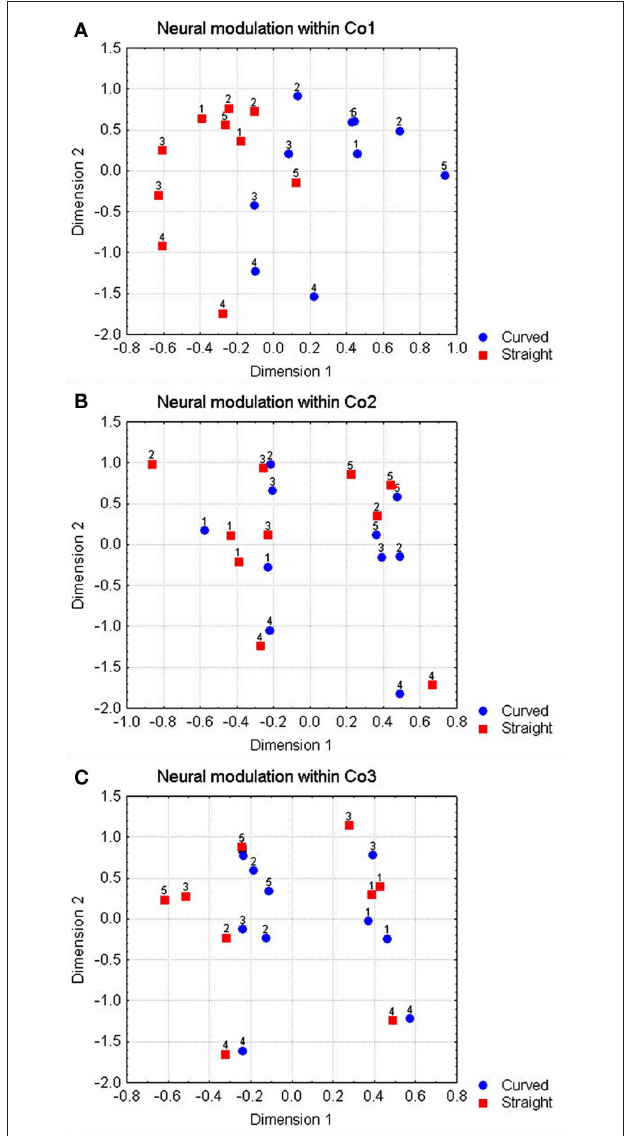
Figure 6 | representation of two dimensions of a 3-D MDS-solution for the shapes within each complexity group of Figure 1, using the neural euclidean distances. Circles indicate curved shapes, squares indicate straight shapes. The horizontal axis shows the dimension that best separates the curved from the straight shapes. (A–C) Contain the solutions for complexity